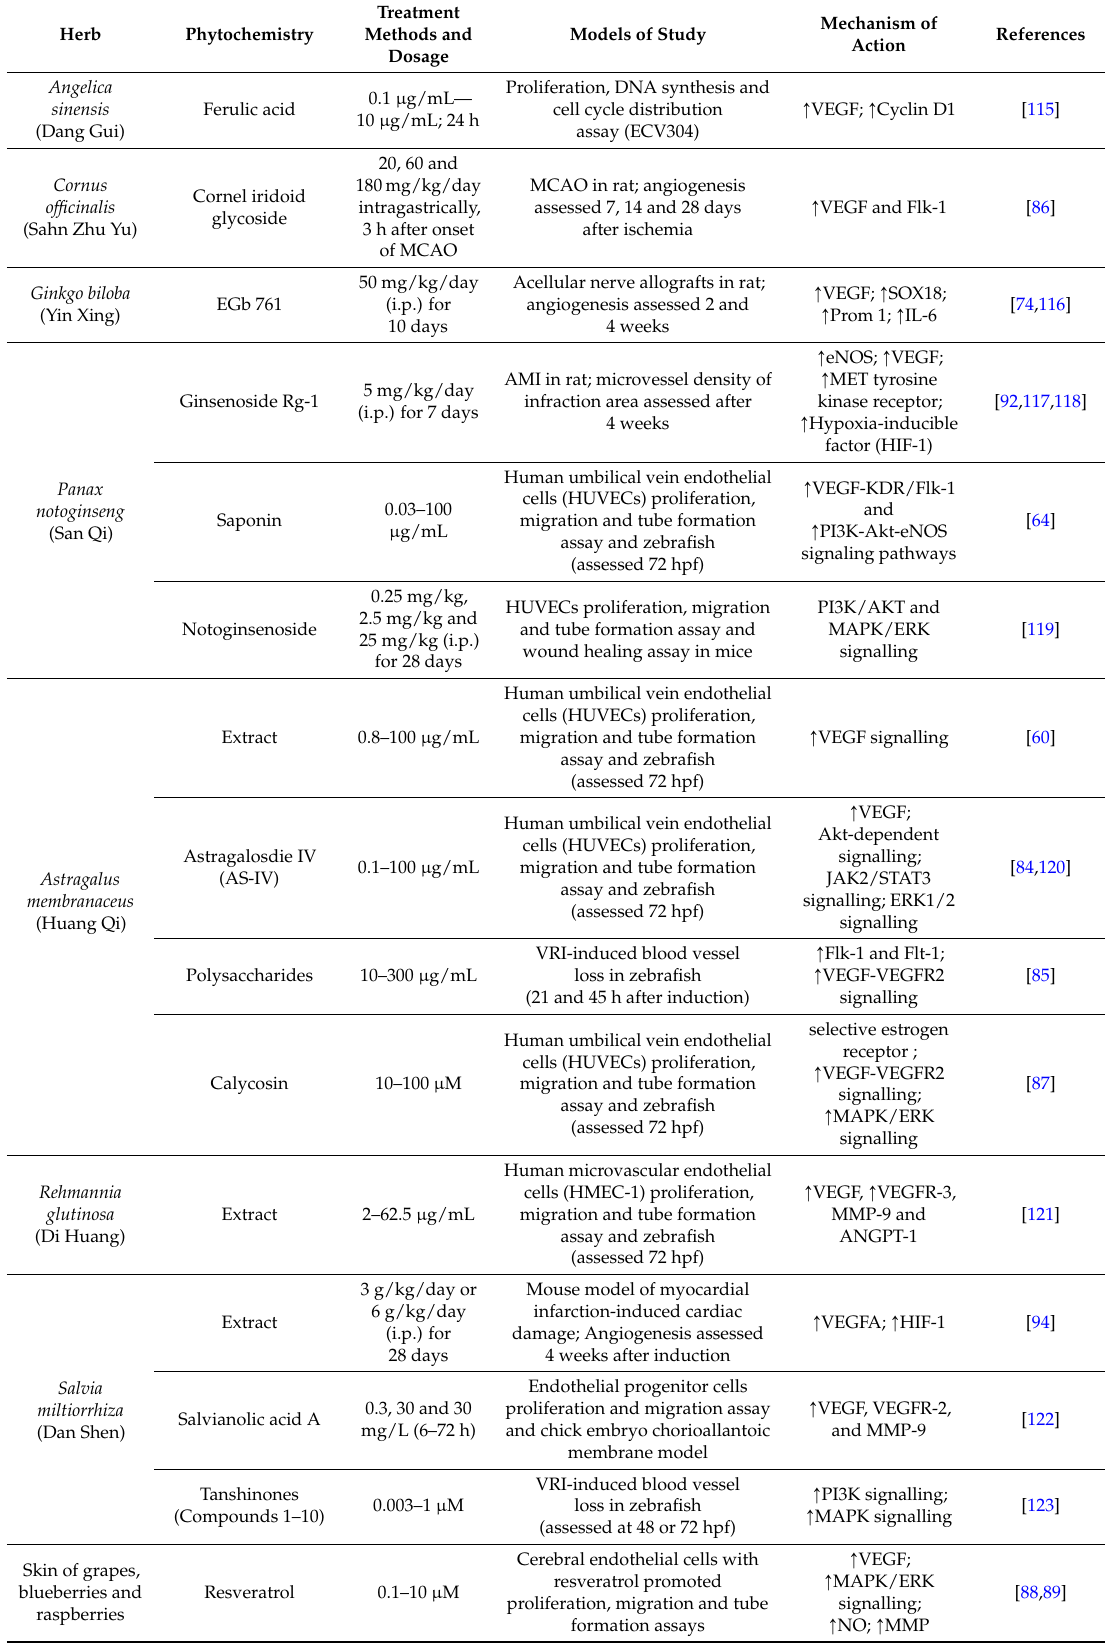
Table 1. Summary of the pro-angiogenic effects of common Chinese herbs and herbal formulations.